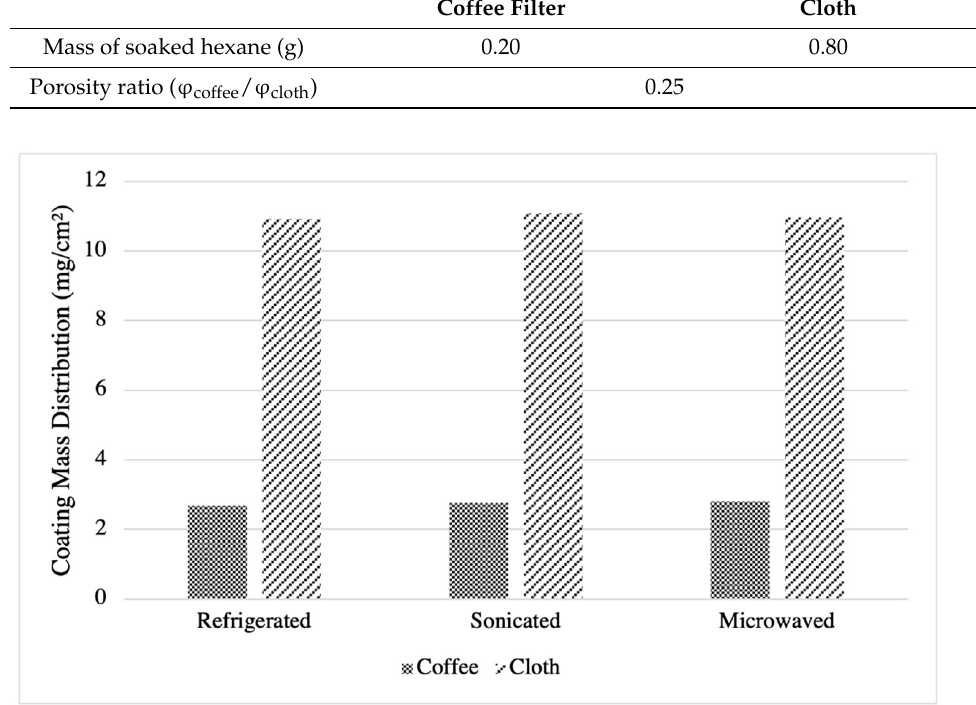
Figure 6. Mass distribution of TiO 2 on filters with different treatment methods.